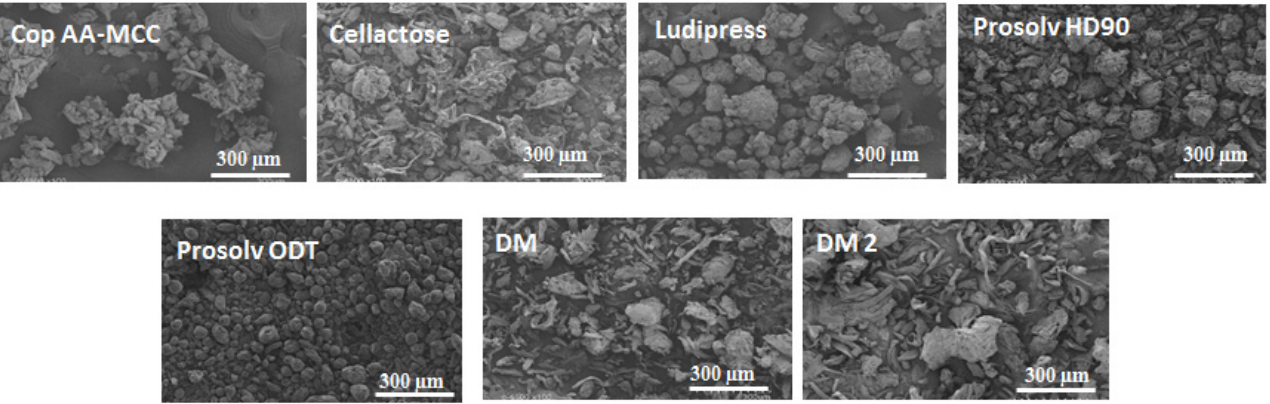
Figure 1. SEM images of the different co-processed excipients (Cop AA-MCC, Cellactose, Ludipress, Prosolv HD90, and Prosolv ODT) and the dry mixtures (DM and DM2).